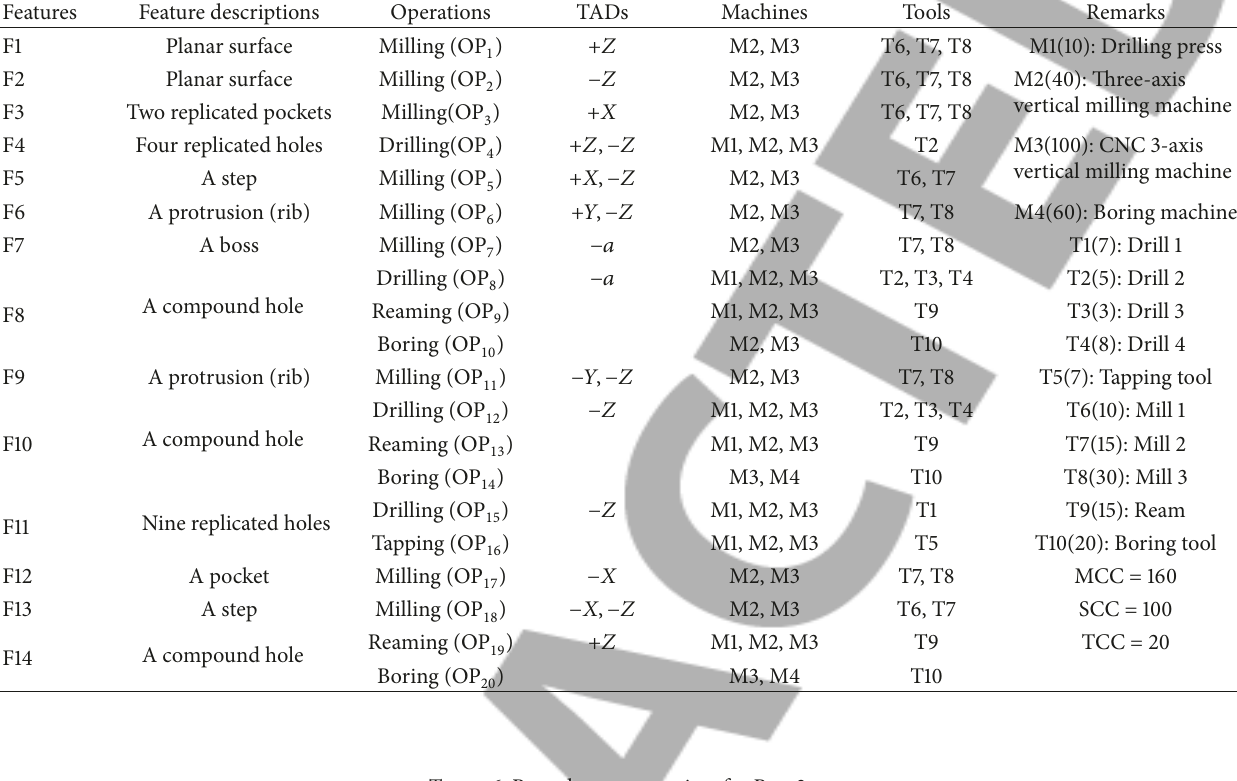
Table 5: Features, operations, and machining information for Part 2.